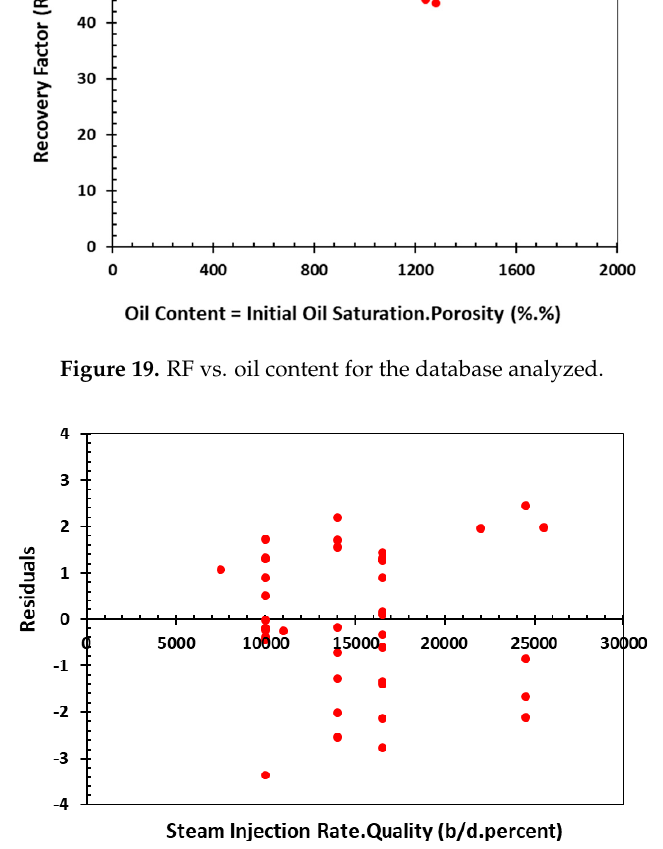
Figure 20. Residuals vs. product of steam injection rate and quality for the database analyzed.